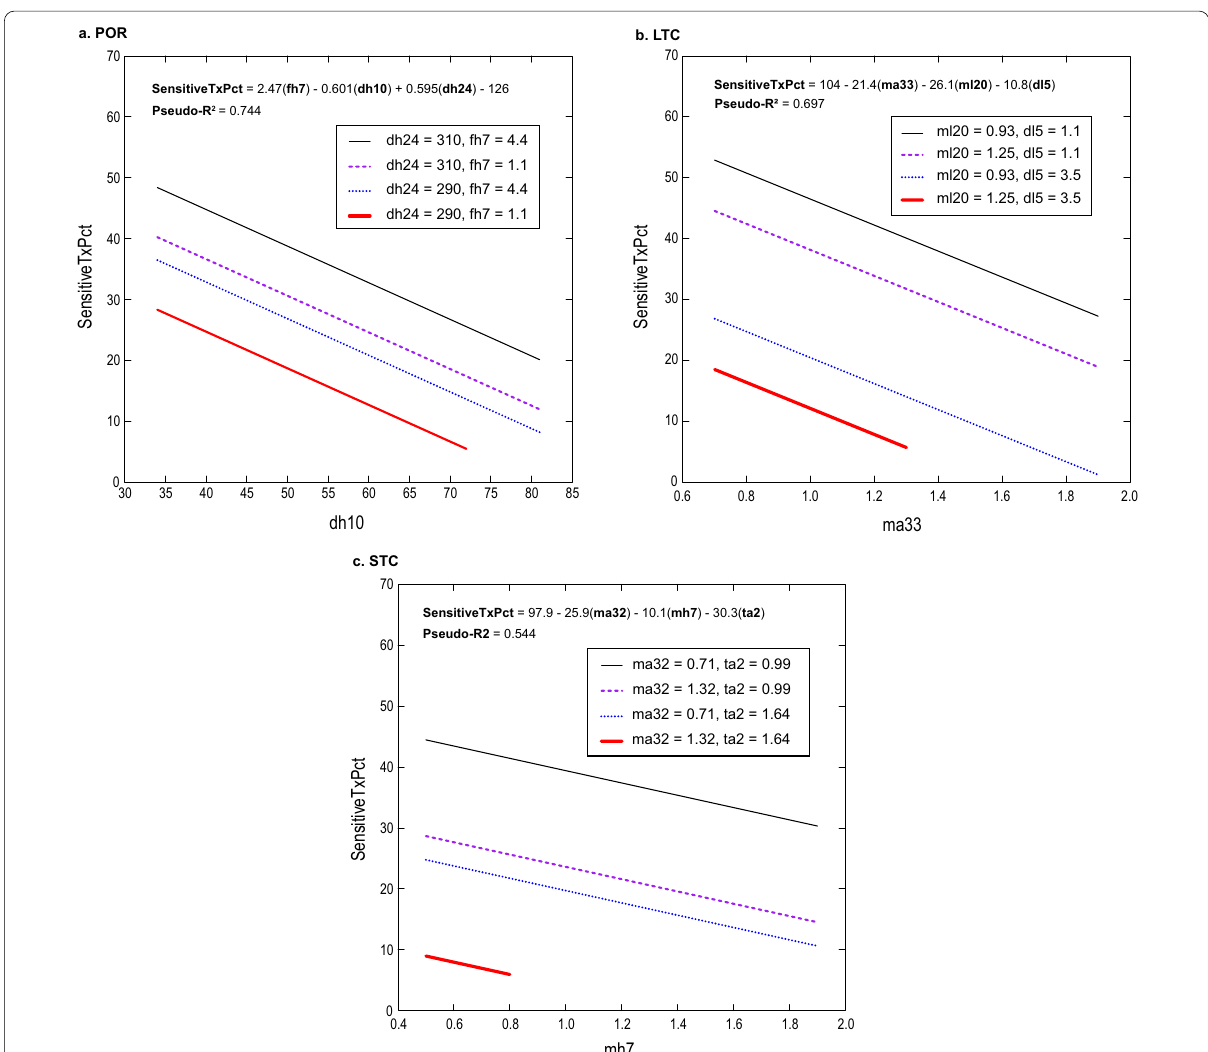
Fig. 7 Plots illustrating the predicted relative abundance of sensitive taxa (SensitiveTxPct) in fish-community samples over a range of the dominant hydrologic explanatory variable and combinations of high and low values of the other two hydrologic explanatory variables for three different hydrologic datasets (Krall et al. 2022): a period of record (POR), b long-term change (LTC), and c short-term change